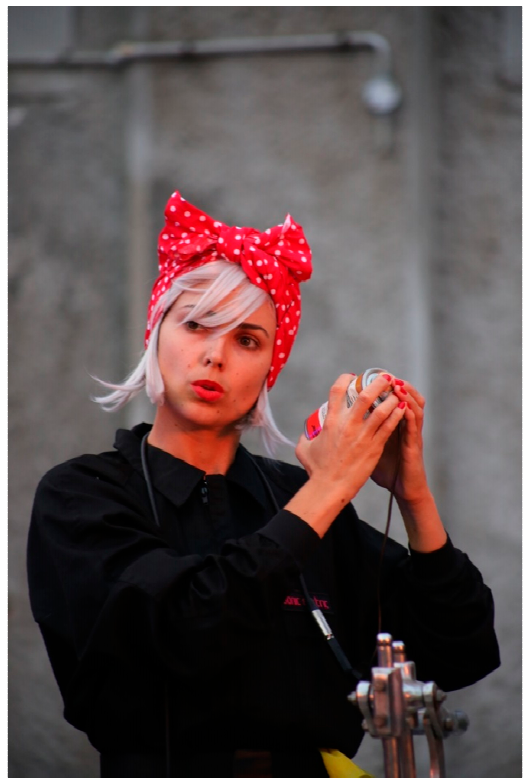
Figure 2. A participant of a Public Kitchen performing in The Future is Female exhibition, Abbotsford Convent, Melbourne, Australia, 2018.